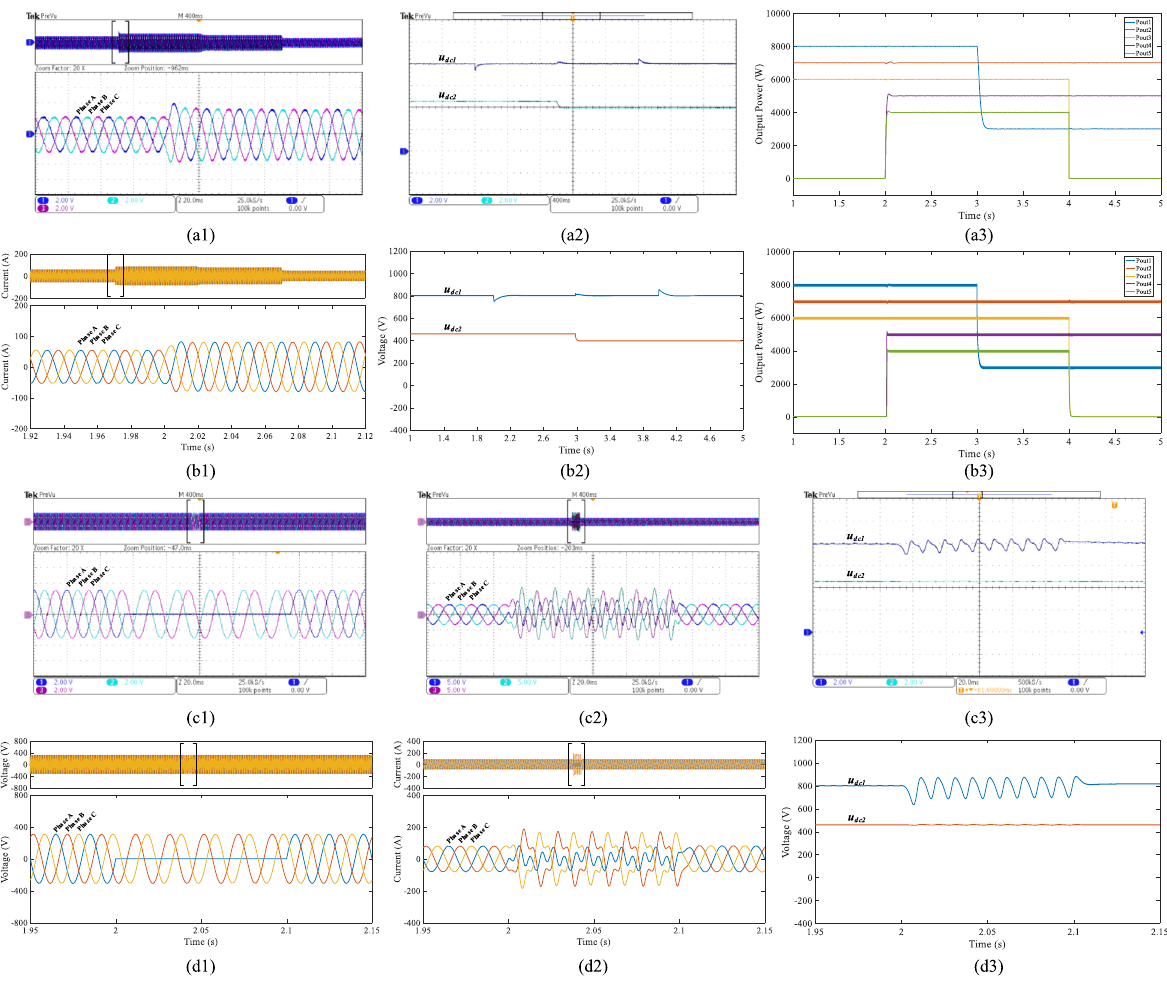
Fig. 8 Transient waveforms of the EV charging station under different